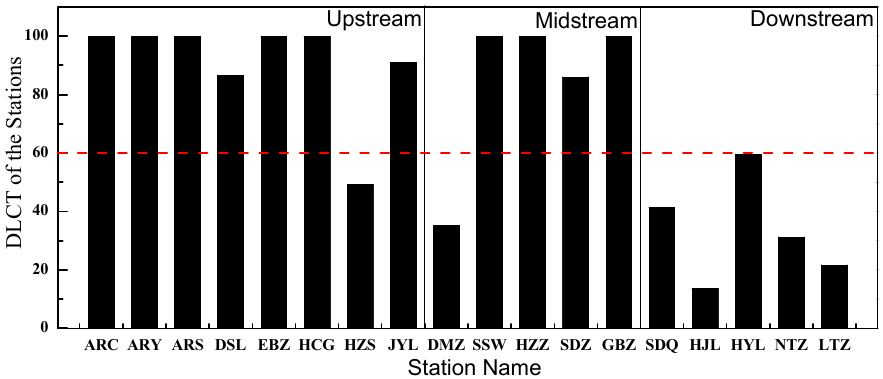
Figure 4. The dominant land cover type ( DLCT) for the HiWATER stations.